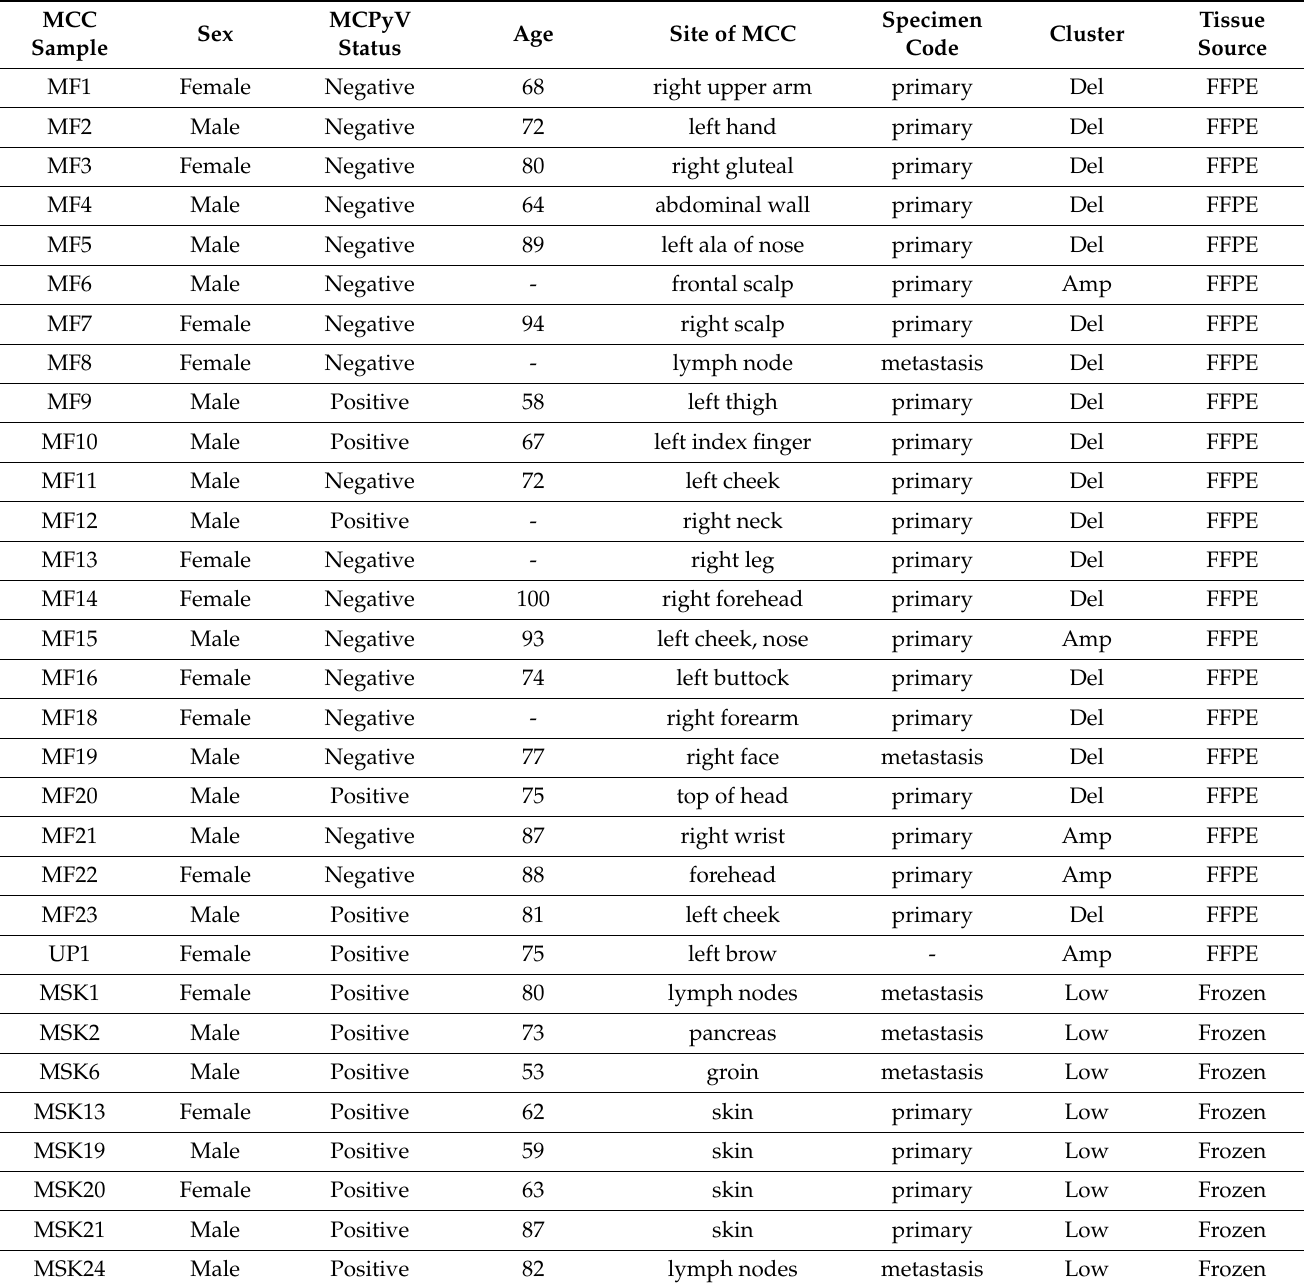
Table 1. Patient